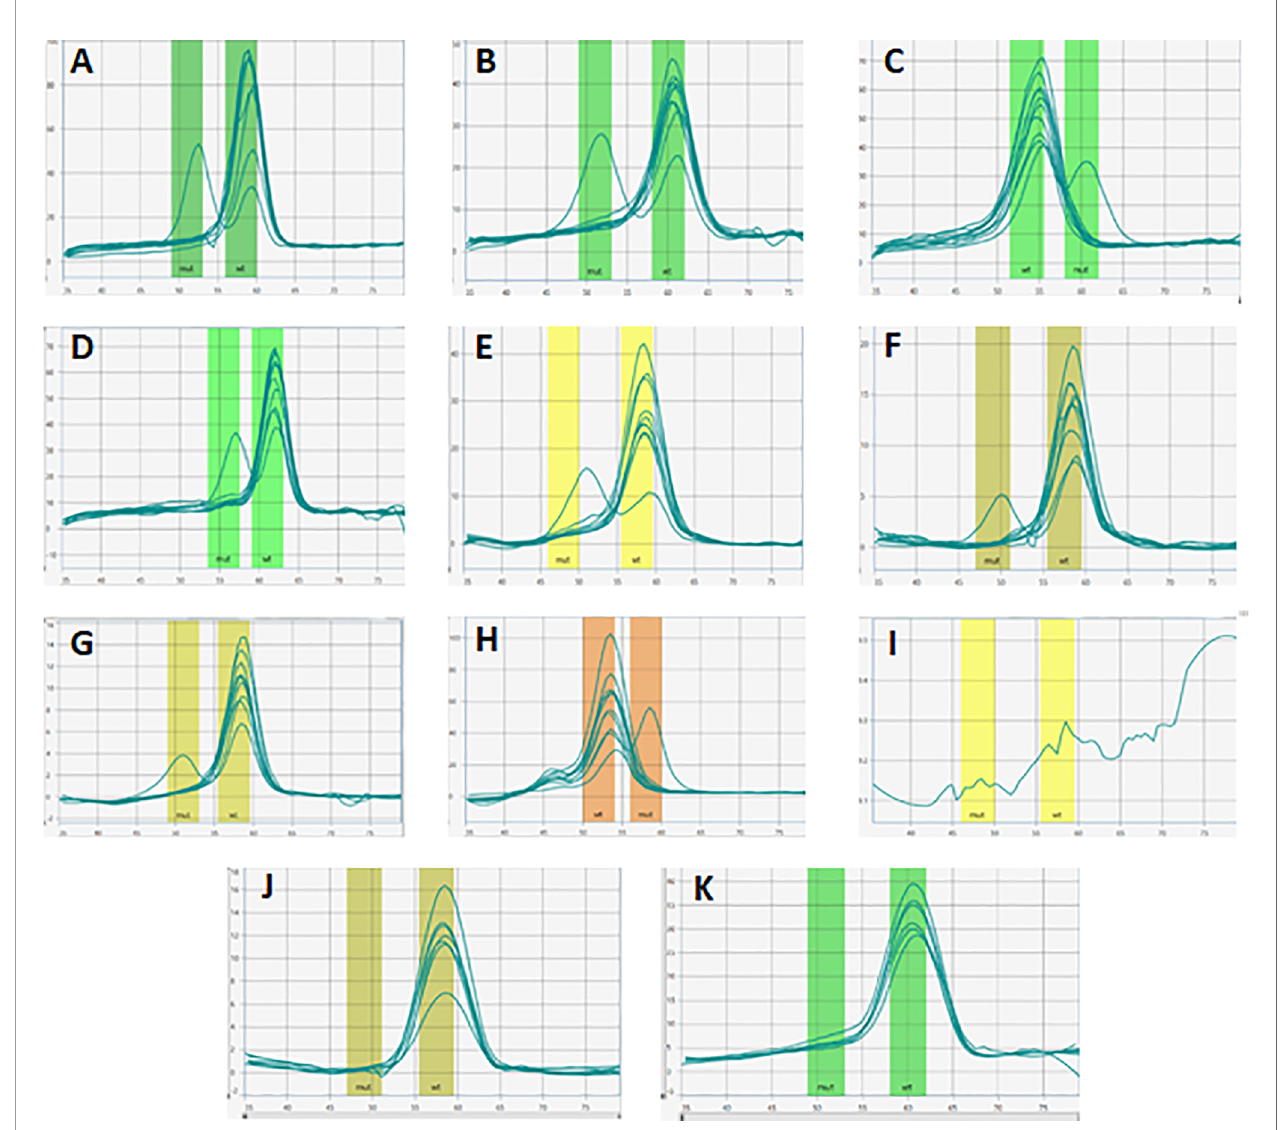
FIGURE 2 | BRCA1/2 genotyping of control samples using the BRCA 1.0 POC assay. Melting curve analysis of founder mutations BRCA1 c.68_69delAG, c.1374delC, c.2641G>T, c.5266dupC and BRCA2 c.5771_5774delTTCA, c.5946delT, c.6447_6448dupTA, c.7934delG (A – H) . By using the HyBeacon FAM probe (green), melting peaks were correctly detected for pathogenic variants BRCA1 c.1374delC (rs397508862) (A) , BRCA2 c.6447_6448dupTA (rs397507858) (B) , BRCA1 c.2641G>T (rs397508088) (C) , BRCA1 c.5266dupC (rs80357906) (D) , while the CAL 560 probe (orange) detected BRCA2 c.5771_5774delTTCA (rs80359535) (E) , BRCA2 c.5946delT (rs80359550) (F) , BRCA2 c.7934delG (rs80359688) (G) and the CAL 610 probe identi fi ed the pathogenic variant BRCA1 c.68_69delAG (rs80357914) (H) with fl uor red dye on the controls with known BRCA1/2 variants. No peaks were detected in (I) , con fi rming the absence of ampli fi cation in the blank sample containing no template DNA. The absence of a second melting curve in (J) and (K) was expected and con fi rmed the negative controls as samples without any speci fi c founder/recurrent pathogenic